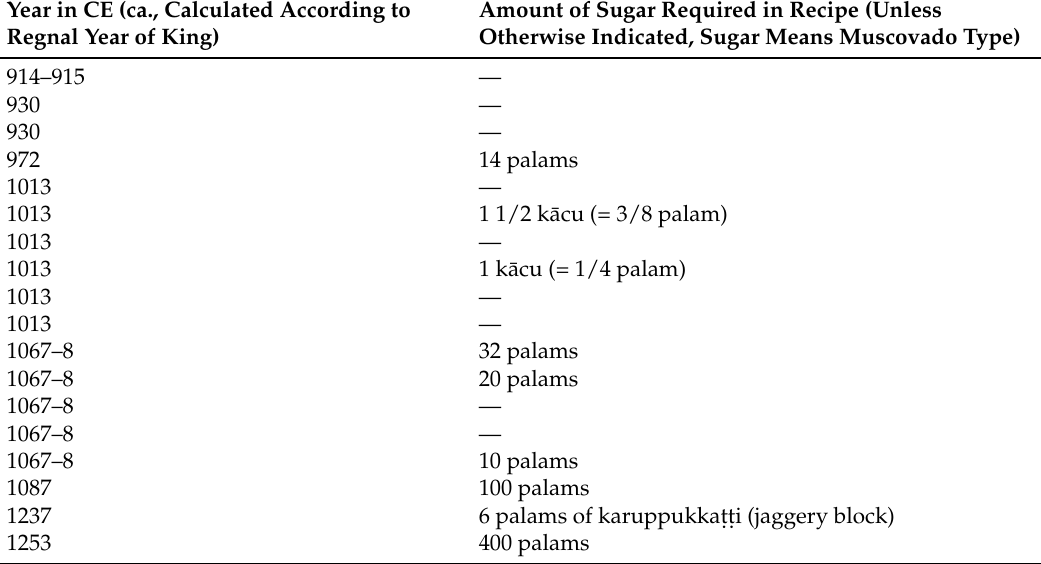
Table 3. C¯ol ¯a data by inscription in chronological